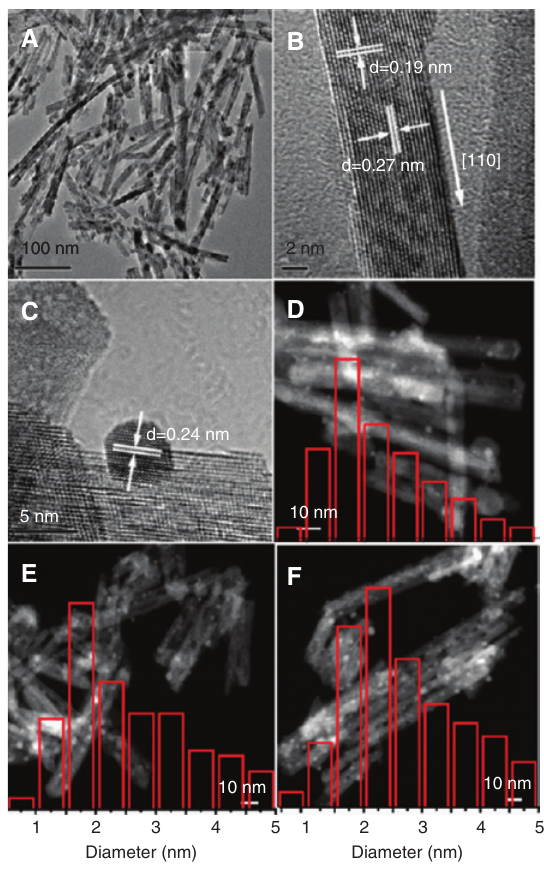
nanorods; 2 catalysts (C); and 2 composites with different 2